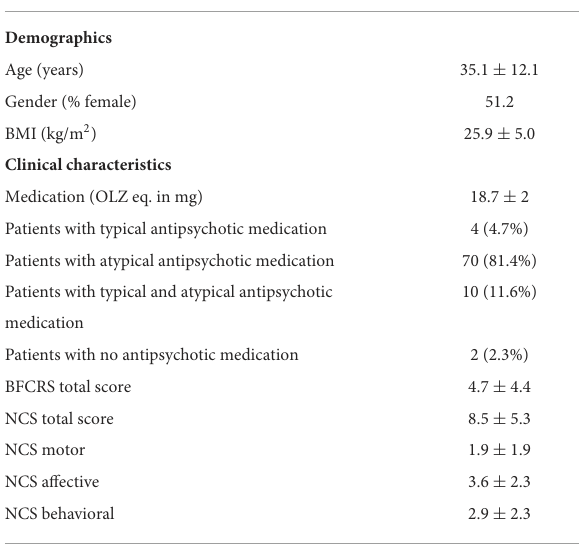
TABLE 1 Demographic and clinical